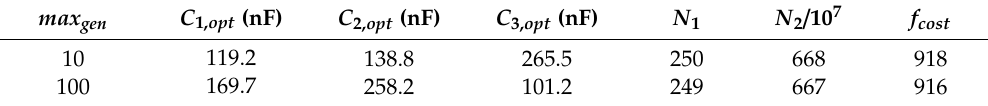
Figure 8. ( a ) Result of the optimization in DF PI after 10 generations (solid red line) and 100 generations (dotted–dashed green line) compared with the mask and the case without decaps. ( b ) Cost function f cost as function of the number of generations when max gen = 10 and max gen = 100. Table 4. Best solution provided by DF PI for the decaps value.